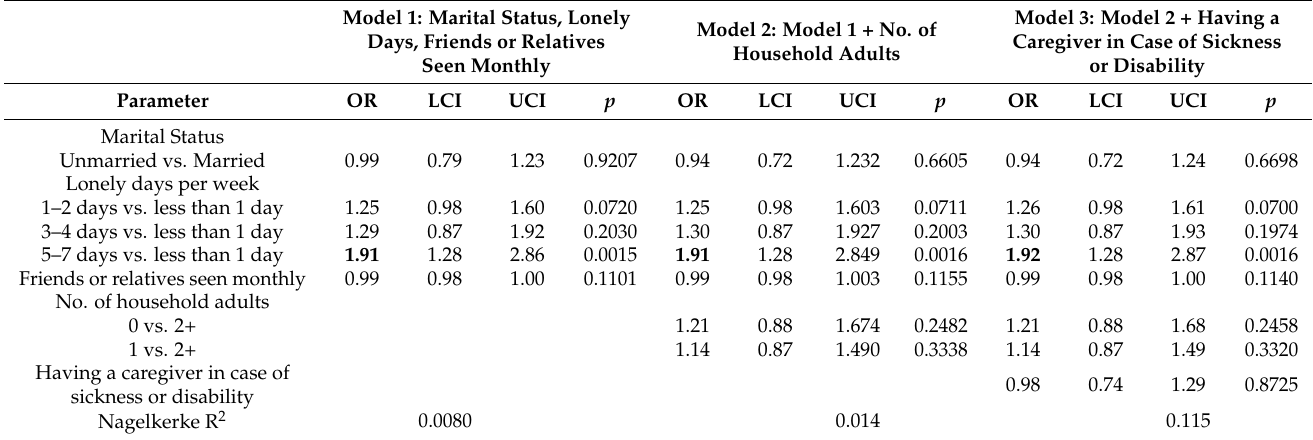
Table 2. Multivariable models of association between cognitive impairment and social variables among REGARDS participants (n =